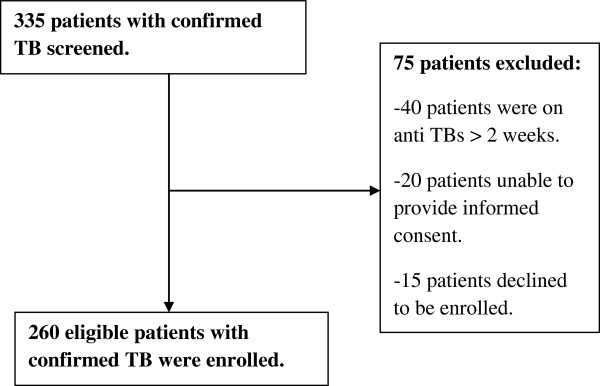
Study screening and enrolment chart.